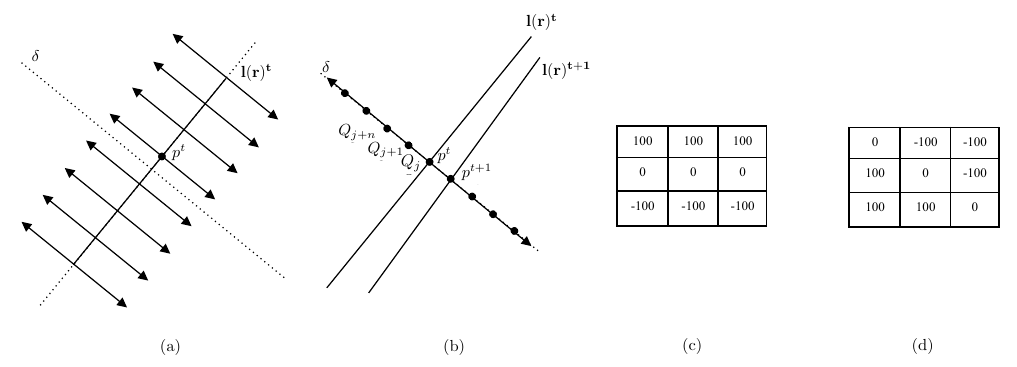
Moving edges (ME) algorithm to find correspondent points in image sequences. the normal direction; ( c ) M δ mask at 180 ◦ and ( d ) M δ mask at 45 ◦